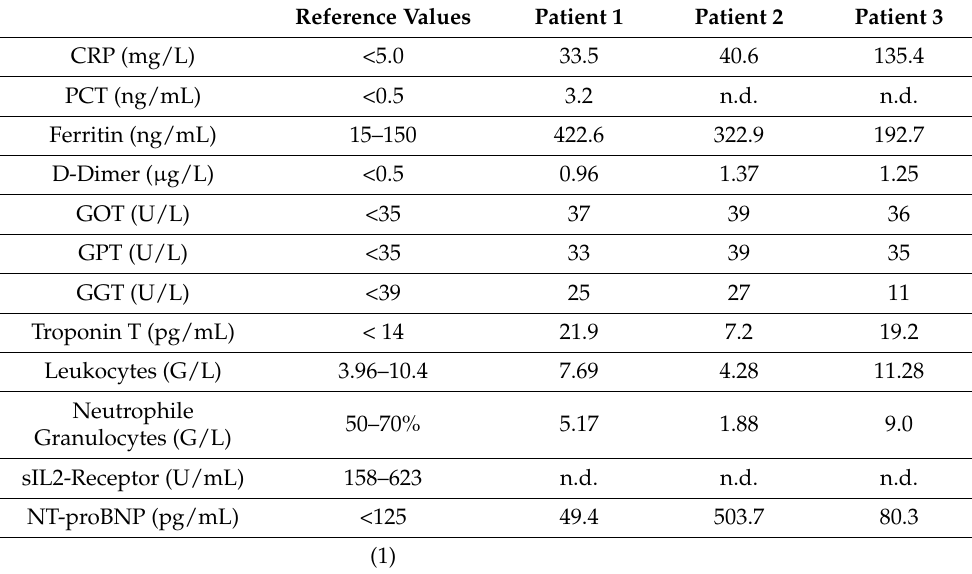
Figure 3. Enhanced echogenicity of right coronary artery (RCA) with normal dimension. Table 4. Laboratory findings after